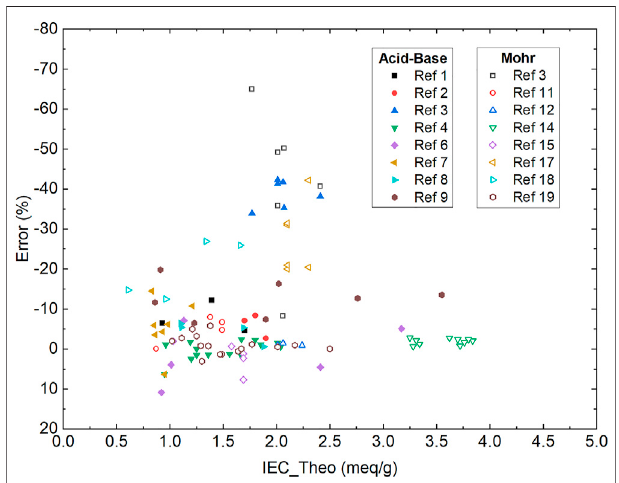
FIGURE 1 | Summary of Errors versus Theoretical IEC values from typical aggregated from the AEMs reported (Si et al., 2014a; Si et al., 2014b; Mohanty et al., 2015; Vandiver et al., 2016; Liu et al., 2018; Liu and Kohl, 2018; You et al., 2018; Allushi et al., 2019; Divekar et al., 2019; Han et al., 2019; Mandal et al., 2019; Pham et al., 2019; Yang et al., 2019; You et al.,2019;Zhuetal.,2019;Ziv etal.,2019;Buggy etal.,2020;Mondaletal., 2020; Yang et al., 2020). The error was calculated as (IEC_Meseaured - IEC_Theoretical)/(IEC_Theoretical) ×